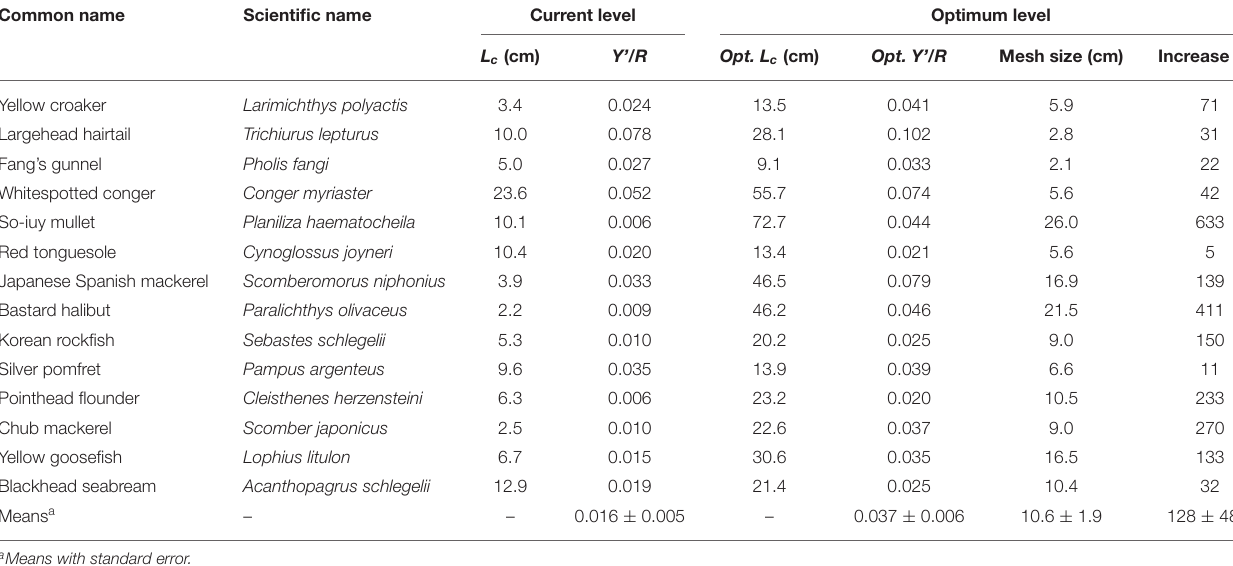
TABLE 5A | Current and optimum yield-per-recruit and mean first capture length of 14 species in China’s coastal